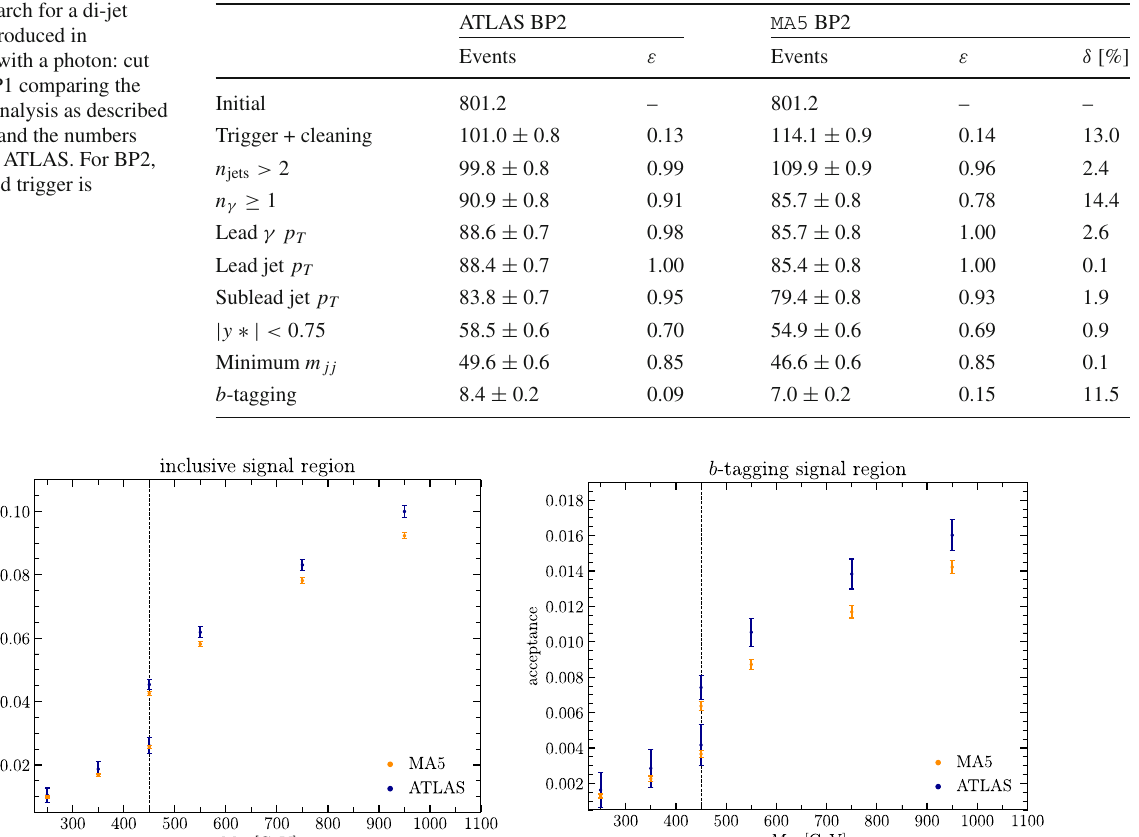
ing after each cut and the associated statistical uncertainty (corresponding to the uncertainty of the MC